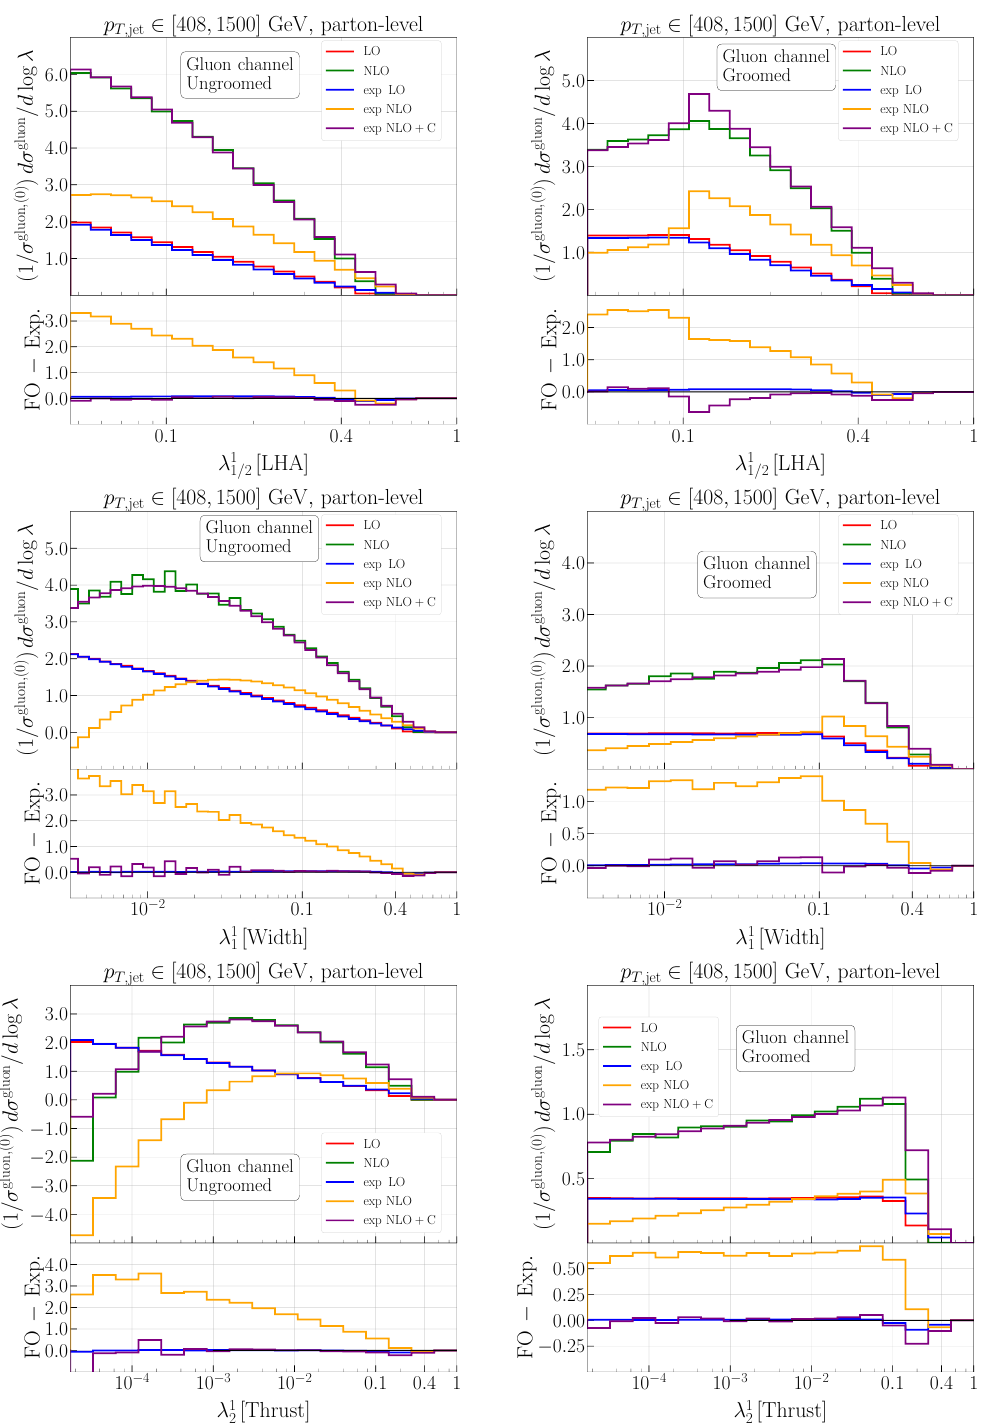
Figure 6 . Fixed-order predictions for the gluon channel, identified with the BSZ algorithm, for ungroomed (left column) and groomed (right column) angularities λ 1 to the expansion of the resummation at the corresponding order of α s , see text for details. The jet transverse momentum is constrained to p T, jet ∈ [408 , 1500]